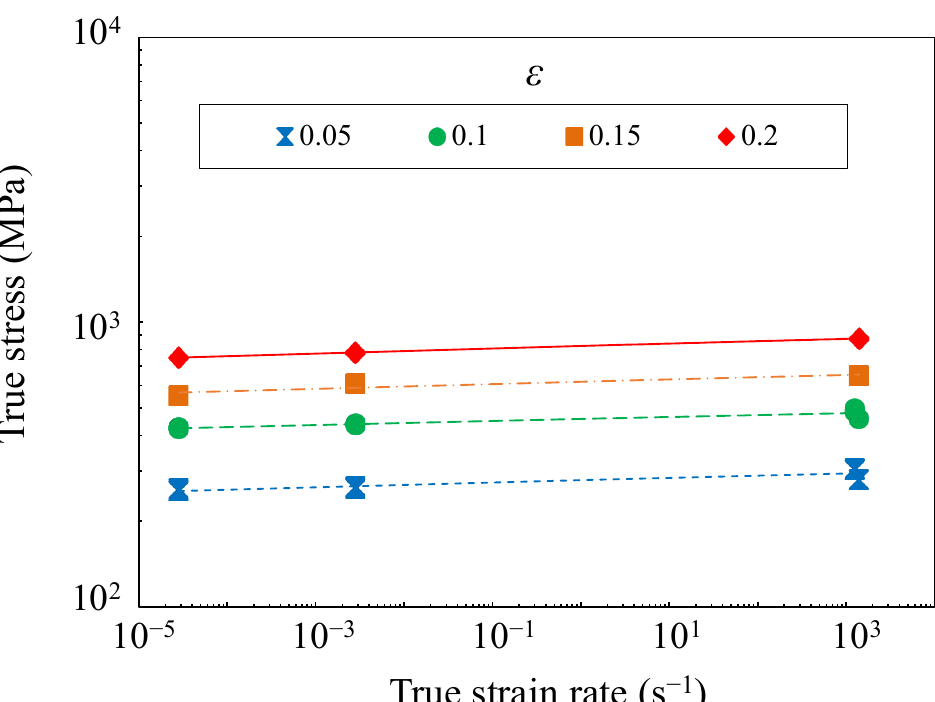
Figure 6. True stress–true strain rate relationships at strains of 0.05 to 0.2 for pure Ni: Results indicate m ≤ 0.009: an exceedingly small value.